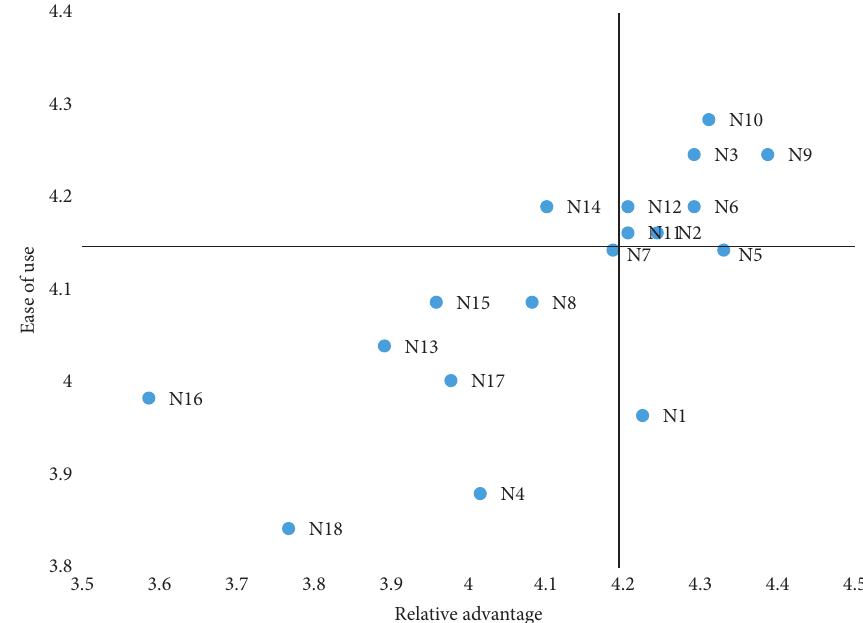
Figure 2: The relationship between the relative advantage and ease of use of the application